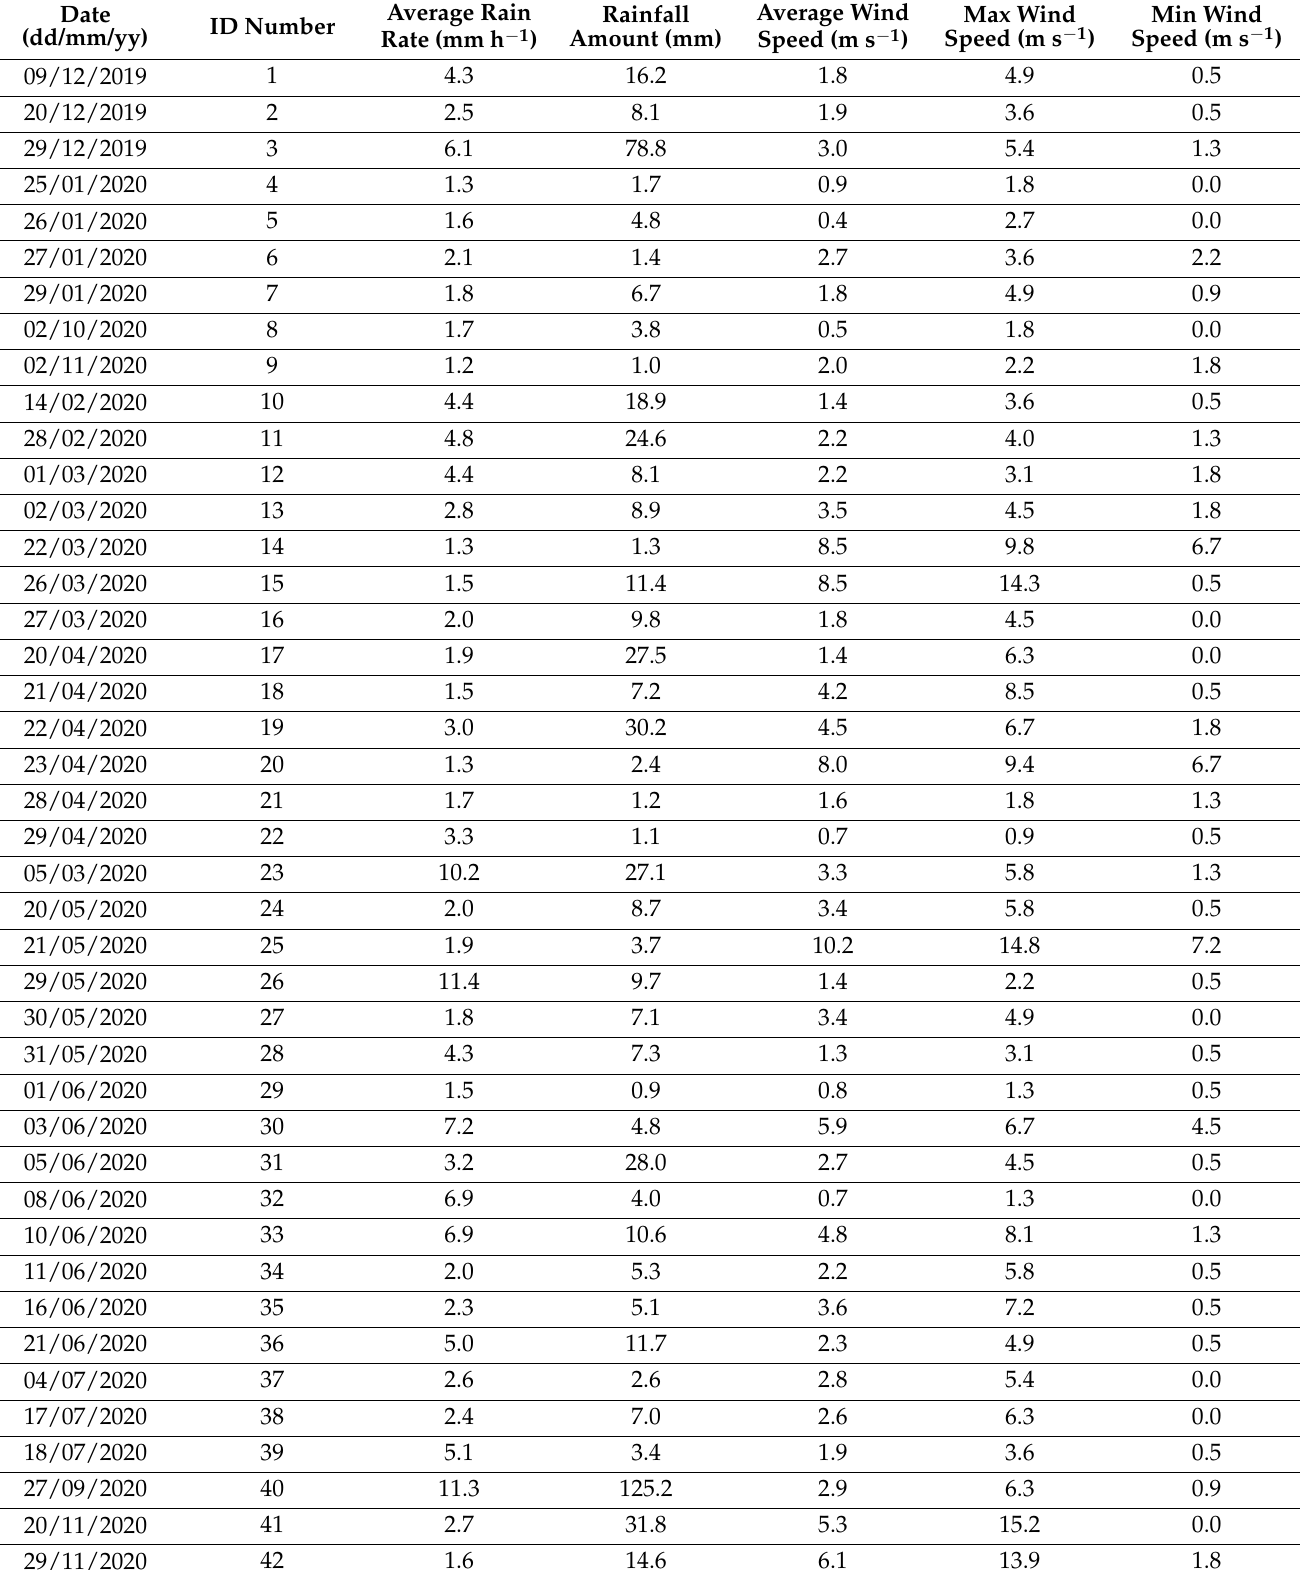
Table 1. List of the selected events including average rain rate (mm h − 1 ) and total precipitation amount (mm) recorded